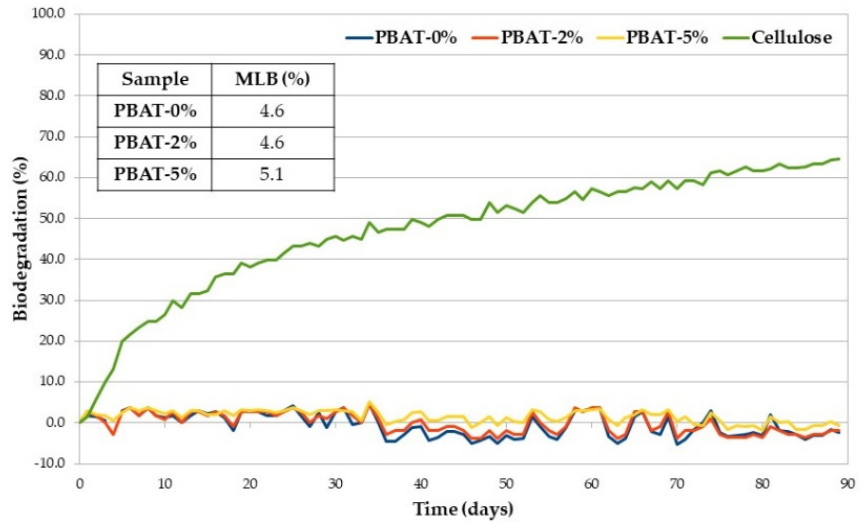
Figure 3. Average biodegradation (%) as a function of time of PBAT samples and cellulose (positive reference).